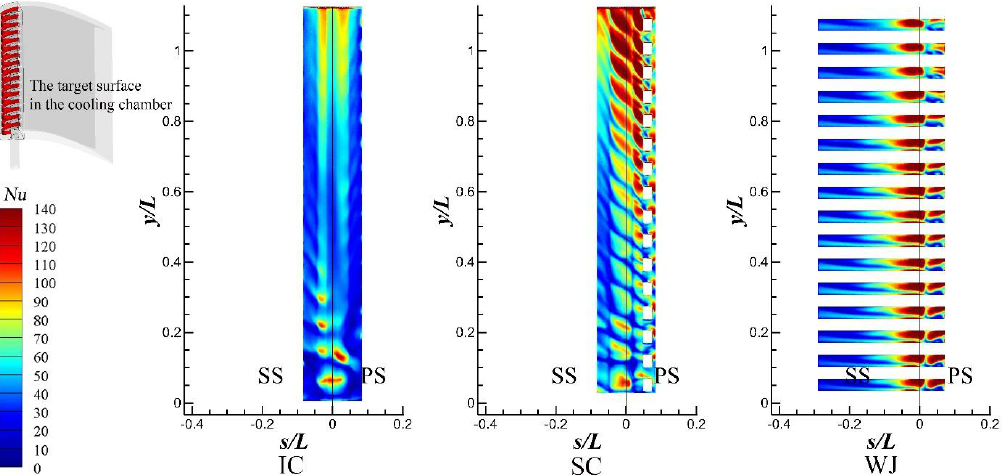
Figure 20. Heat transfer coefficient distribution on target surfaces of different internal cooling structures ( Re j = 20,000).